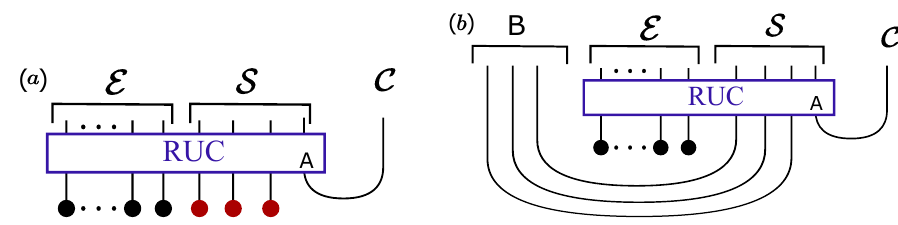
Figure 8 . Pictorial representation of the two settings considered in section 4. In the (cid:12)rst case [sub(cid:12)gure ( a )], we initialize the system (the \black hole") in a product state. A qudit A is initially S injected into the black hole, and a third party ( ) holds a reference system, namely an ancilla which C is maximally entangled with the former at time t = 0. The system is in contact with (representing E the exterior of the black hole, including Hawking radiation) and evolved by the RUC introduced in section 2. In the second setting [sub(cid:12)gure ( b )], the retriever ( B ) initially holds a copy of the black hole, namely is initialized in a maximally entangled state with a set of ancillary S